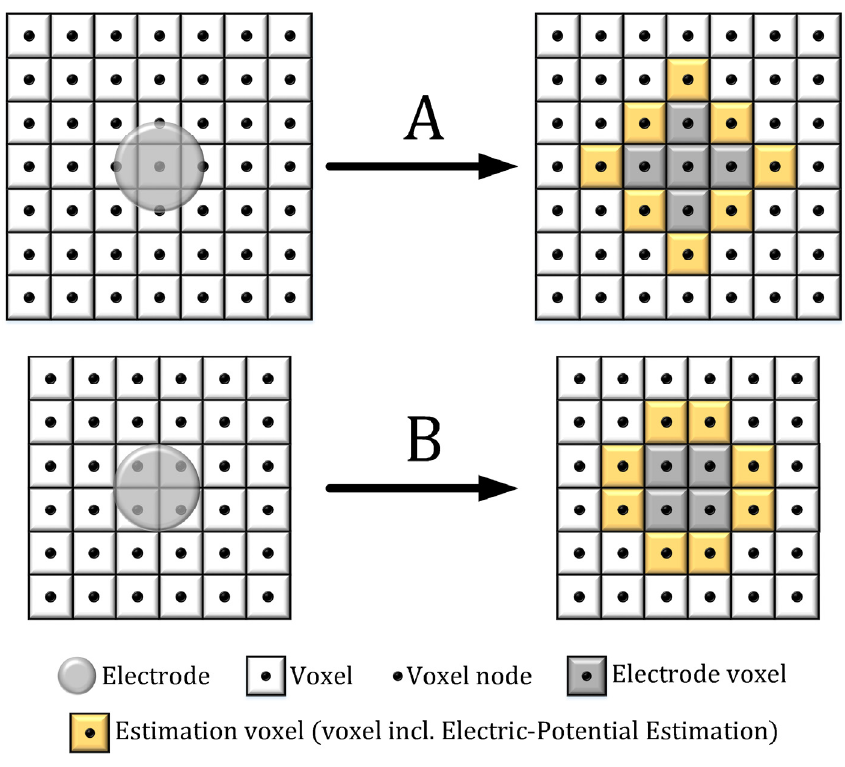
Figure 2. The estimation voxels (orange) neighboring on the electrode voxels (grey voxels) in case of ( A ) centralized grid, or ( B ) shifted grid.